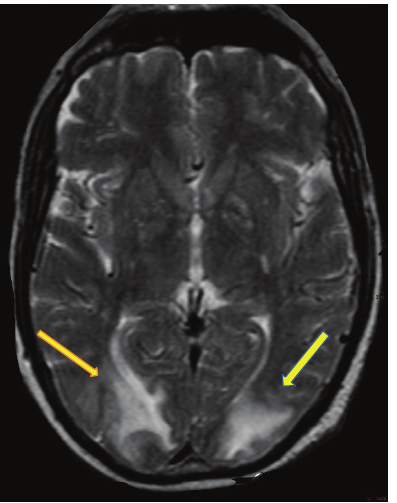
Figure 2: Increased fluid-attenuated inversion recovery (FLAIR) uptake sequence on cerebral occipital parietal